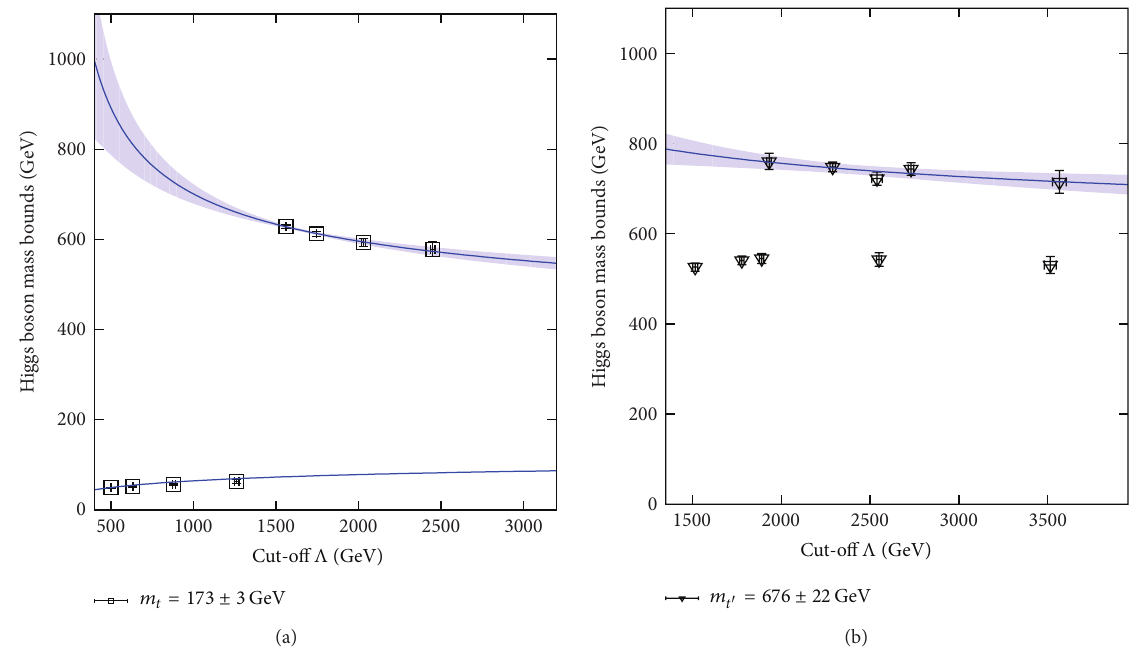
Figure 4: The cutoff dependence of the upper and lower Higgs boson mass bounds for fermion mass at ∼ 173GeV (a) and ∼ 676 GeV (b). All data have been extrapolated to infinite volume.